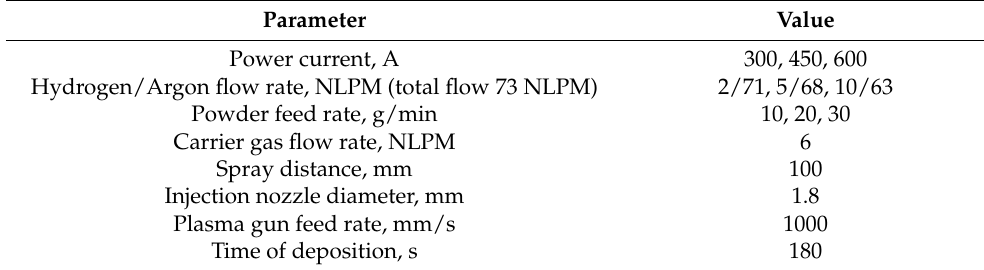
Table 1. The variable and constant plasma-spraying parameters used in